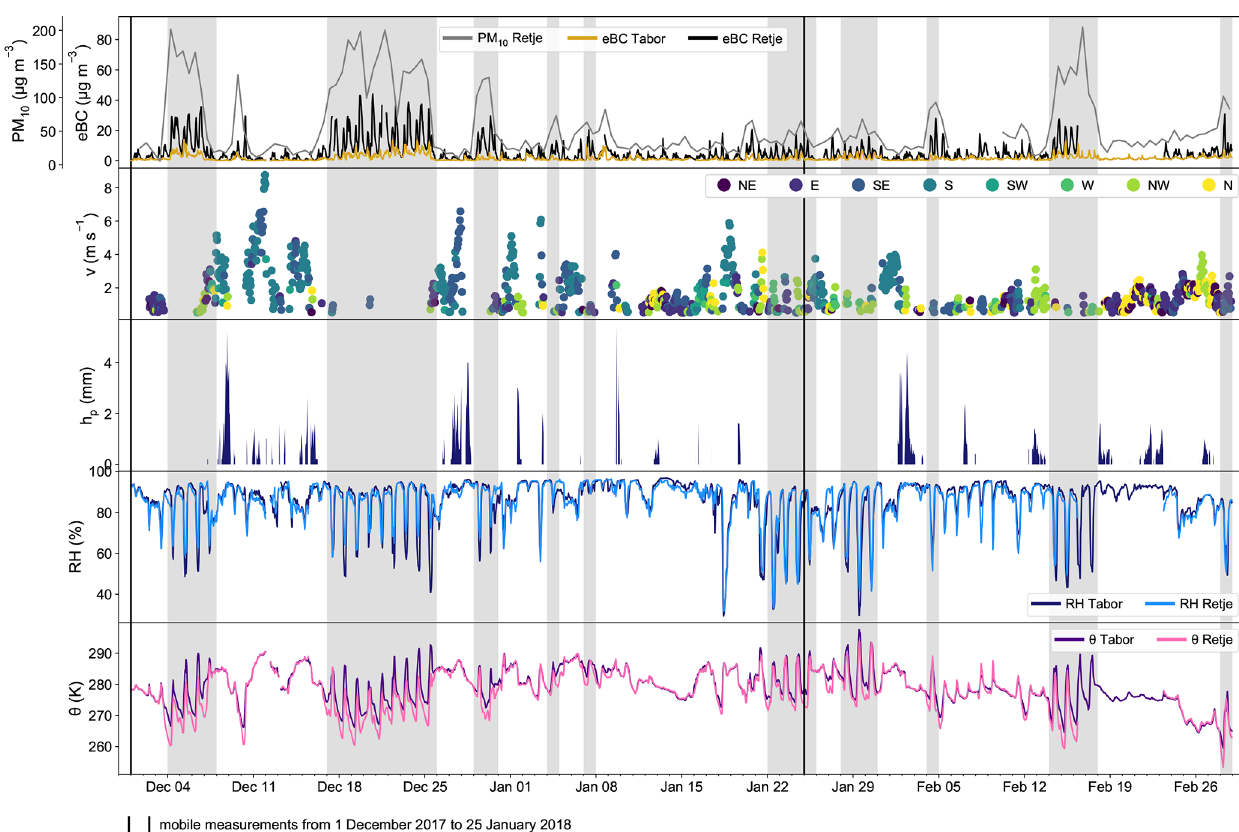
Figure 2. Time series of meteorological and air quality data for the winter period (1 December 2017–1 March 2018): the 12h PM 10 mass concentrations at Retje, the hourly mean eBC mass concentrations at Retje and Tabor, wind speed ( v ) and direction at Hrib, precipitation ( h p ) at Hrib, and relative humidity (RH) and potential temperature ( θ ) at Retje and Tabor. The shaded areas represent temperature inversion